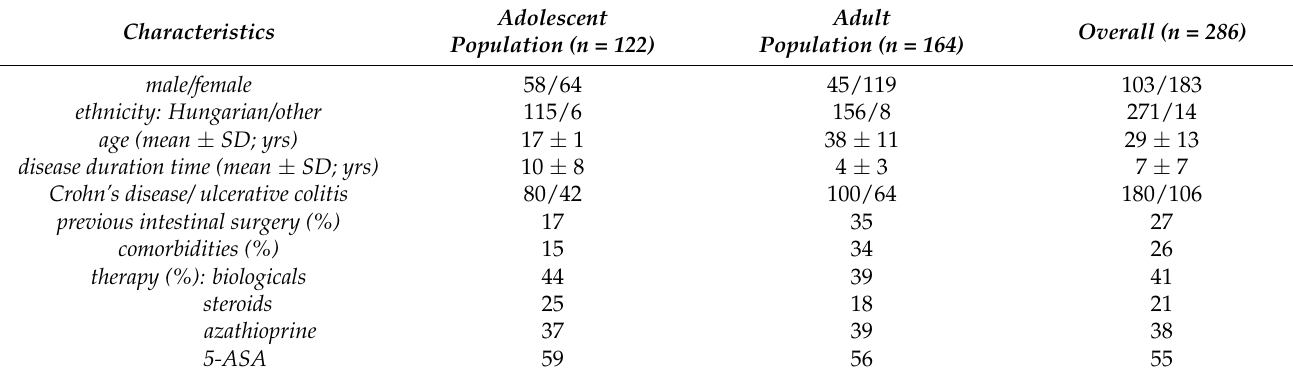
Table 1. Main characteristics of the adolescents and adult patients